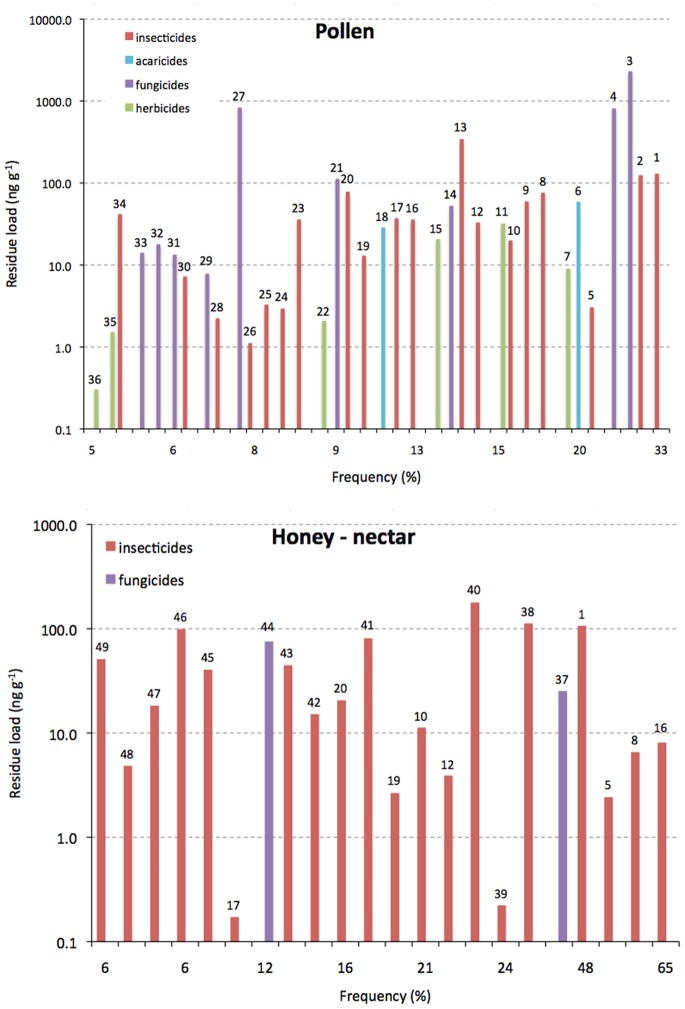
Residue loads of the most common pesticides plotted against their prevalence (frequency) in: A) pollen; B) honey or nectar.Key: 1 coumaphos (total); 2 tau-fluvalinate; 3 thymol; 4 chlorothalonil; 5 acetamiprid; 6 amitraz (total); 7 dithiopyr; 8 thiacloprid; 9 carbaryl; 10 imidacloprid (total); 11 pendimethalin; 12 chlorpyrifos; 13 phosmet; 14 carbendazim; 15 atrazine; 16 thiamethoxam; 17 chlorfenvinphos; 18 fenpyroximate; 19 clothianidin; 20 endosulfan (total); 21 thiophanate-methyl; 22 metolachlor; 23 fenpropathrin; 24 methoxyfenozide; 25 esfenvalerate; 26 tebufenozide; 27 captan (total); 28 bifenthrin; 29 azoxystrobin; 30 lambda-cyhalothrin; 31 diphenylamine; 32 penconazole; 33 trifloxystrobin; 34 fenthion; 35 norflurazon; 36 metribuzin; 37 hexachlorobenzene; 38 HCH (alpha and beta); 39 phorate; 40 gamma-HCH (lindane); 41 heptenofos; 42 methiocarb; 43 DDT (total); 44 vinclozolin; 45 methidathion; 46 malathion; 47 cypermethrin; 48 dimethoate; 49 carbofuran (total).